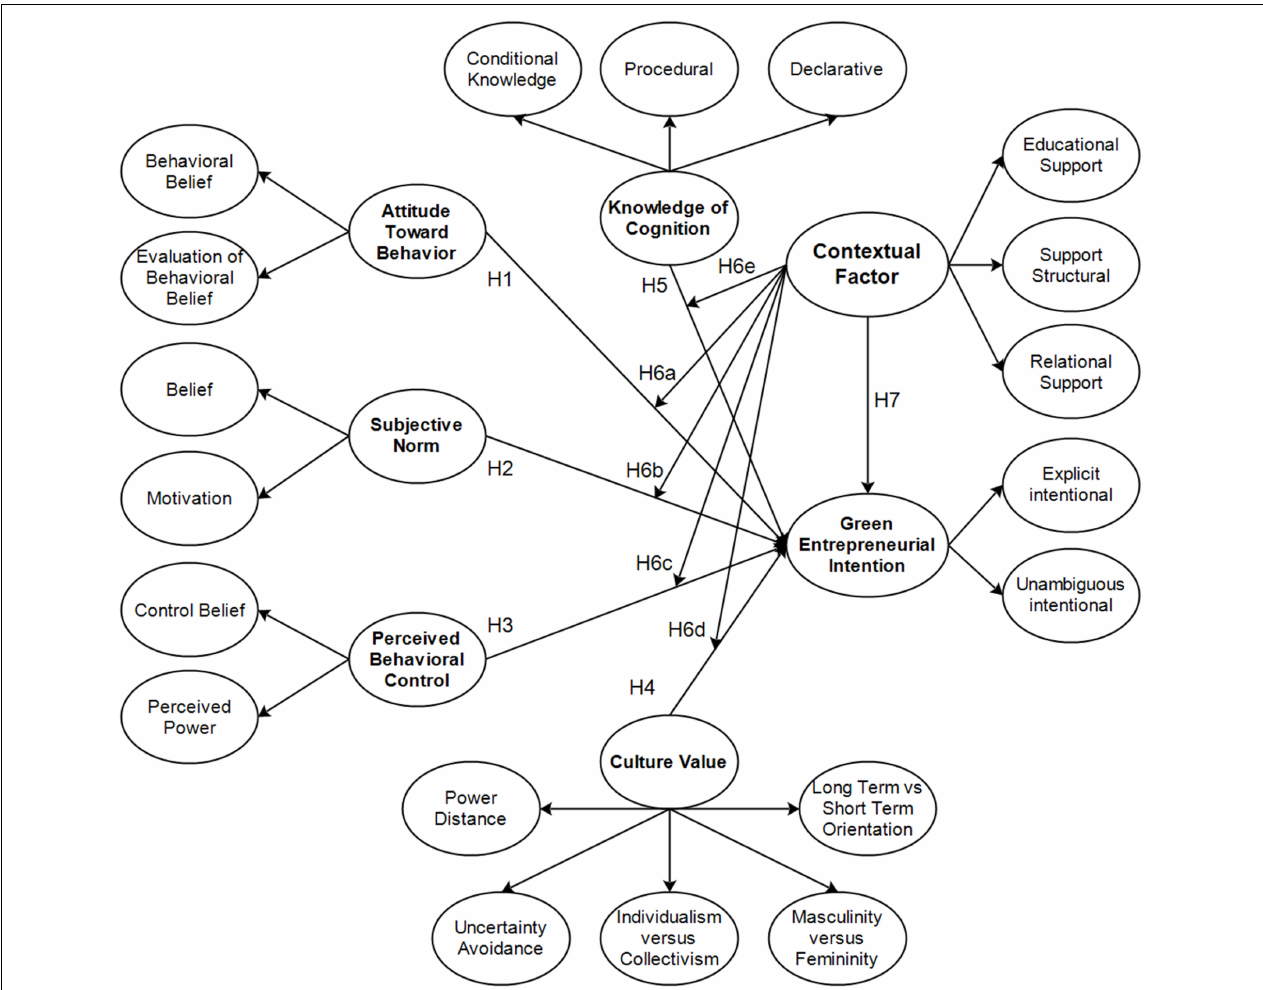
FIGURE 1 | The research